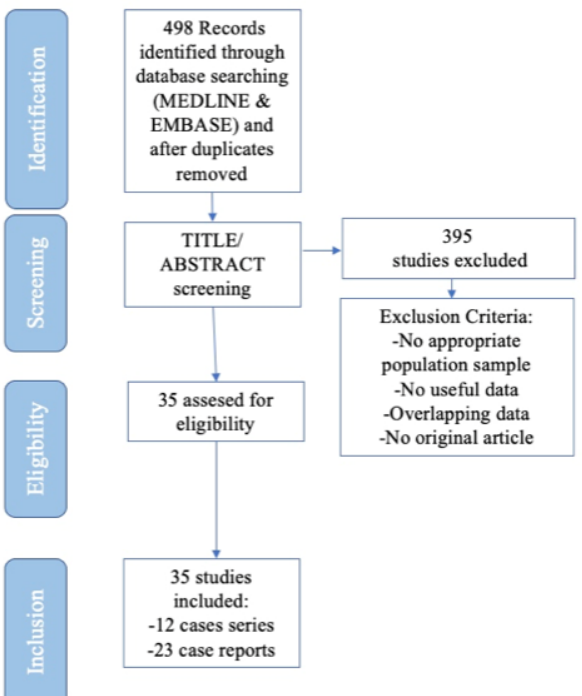
Figure 1. Flow chart highlighting the process of study selection for each step of the Systematic Figure 1. Unconstrained A-B-C model with path coe ffi cients and statistical significance. ** p < 0.01. β Review, following Preferred Reporting Items for Systematic Reviews and Meta-Analyses (PRISMA) values for boys are above the path and β values for girls are below the path.